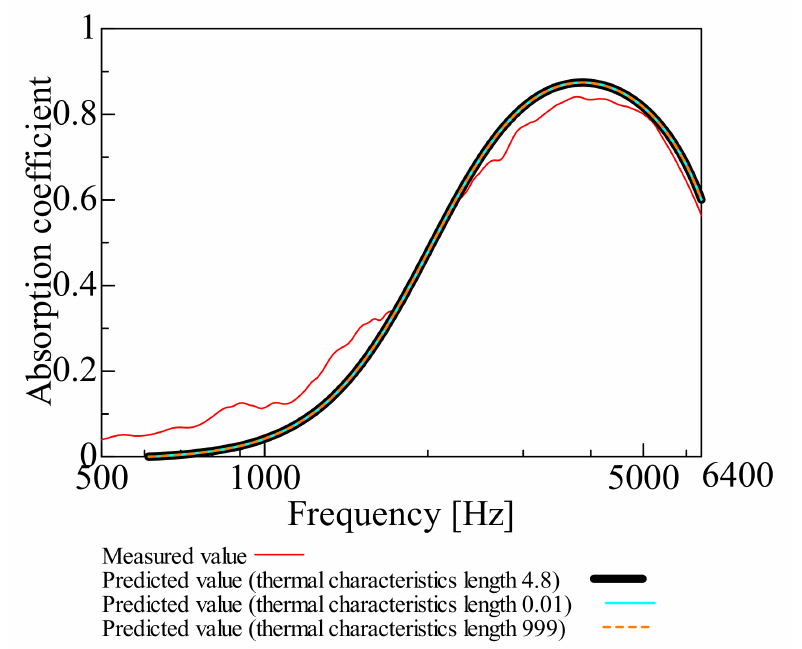
Figure 6. Variation of predicted value due to variation in thermal characteristic length: thermal characteristics length 0.01, 999, and